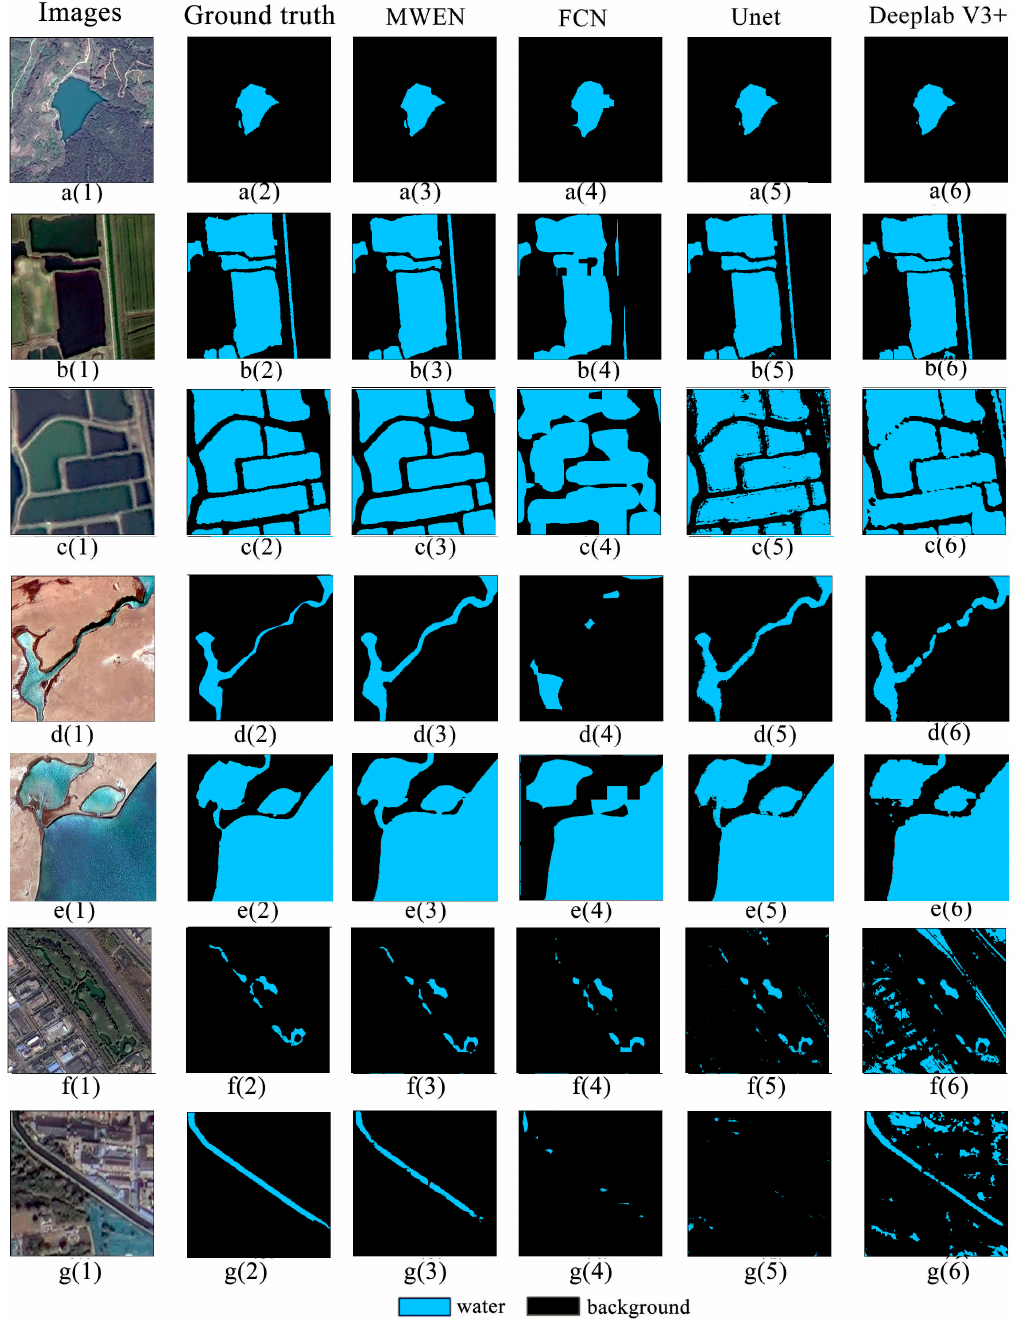
Figure 10. Typical surface water classification results. a(1) is the original image with open pools, and a(2–6) represent the water body information extracted from a(1) by artificial interpretation, MWEN, FCN, Unet, DeepLab V3+, respectively. Additionally, b, c, d, e, f, g give the experimental results of water body extraction from di ff erent images with agricultural water, plateau river, plateau lakes, small water bodies, and tiny rivers, respectively. Blue parts of the pictures are the extracted water bodies and black parts of the pictures are the